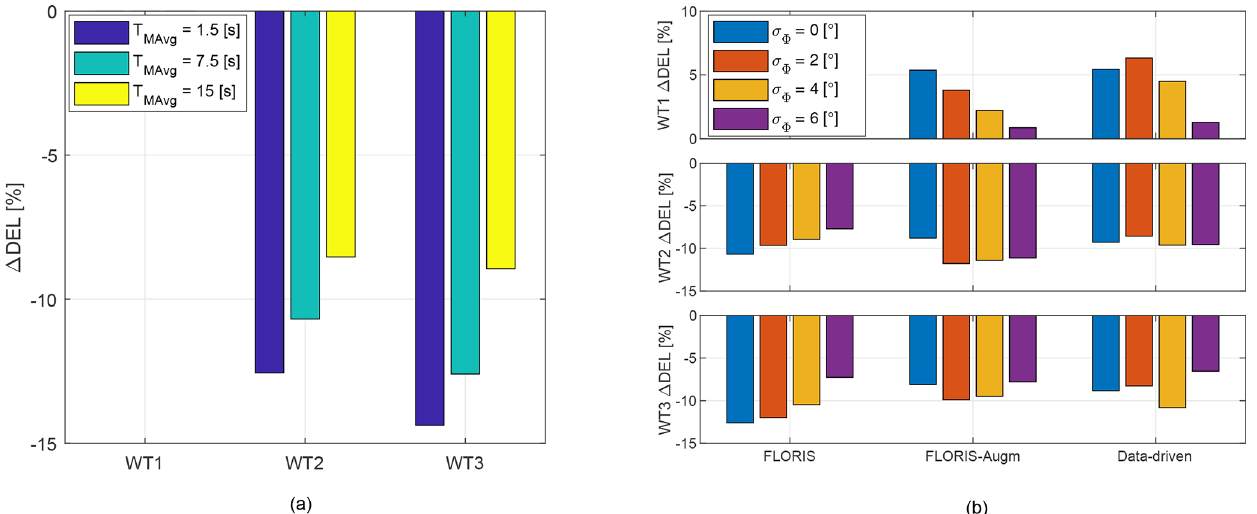
Figure 18. Change in combined rotating shaft DELs with respect to the greedy case. (a) Effect of direction uncertainty: non-robust LUT for the baseline FLORIS model and varying T MAvg . (b) Effect of robustness and model fidelity: LUTs for the three models and increasing robustness, for a wind direction signal filtered with T MAvg = 7 .